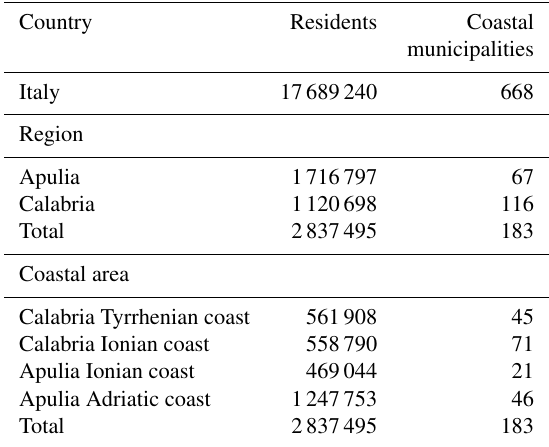
Table 1. Total population per country, region and coastal area. Country Residents